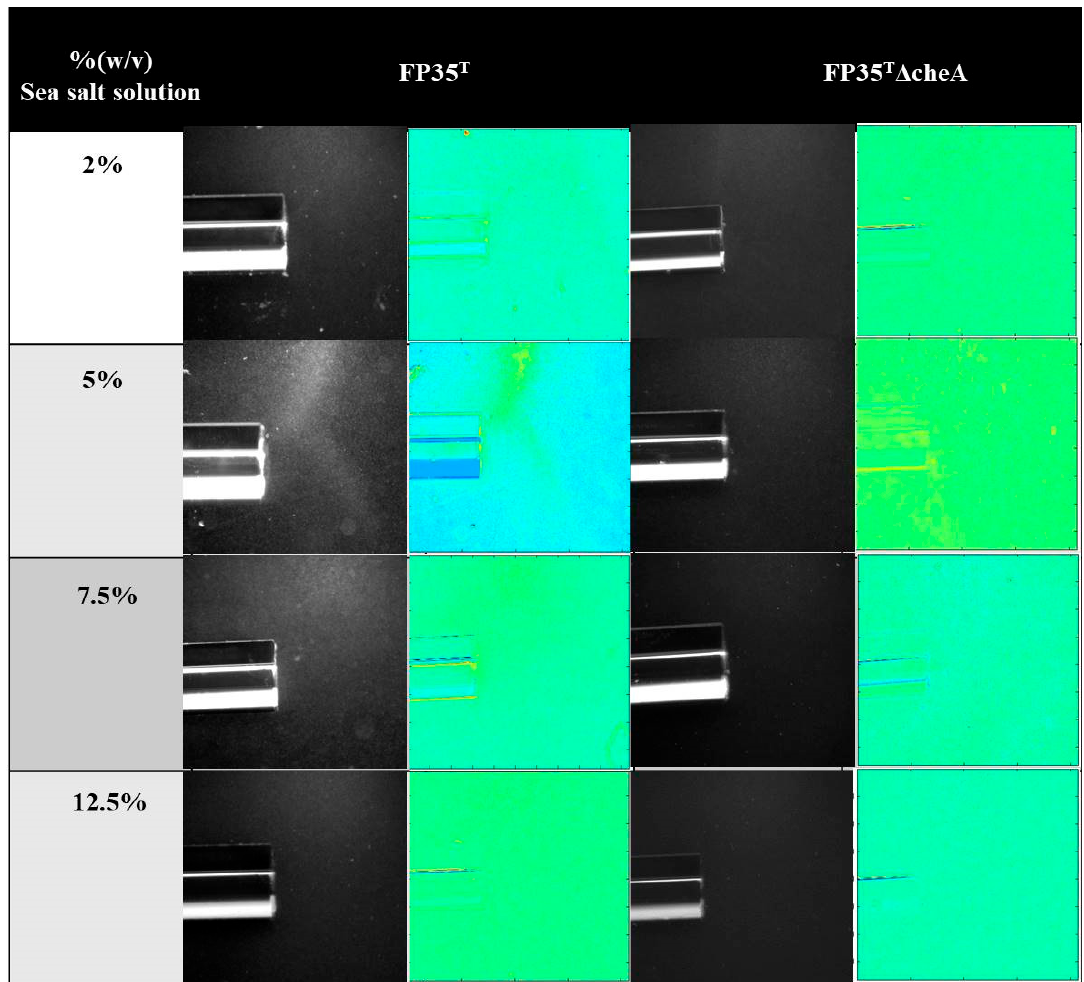
Figure 1. Qualitative capillary chemotaxis assays comparing responses of wild-type H. anticariensis FP35 T and the mutant strain FP35 Δ cheA to root exudates grown at different sea salt solution concentrations. All photographs were taken after 10 min. First and third columns: dark-field images of cells gathered at the mouth of capillary tubes containing attractants; second and fourth columns: heat map of normalized images (Matlab R2013a).